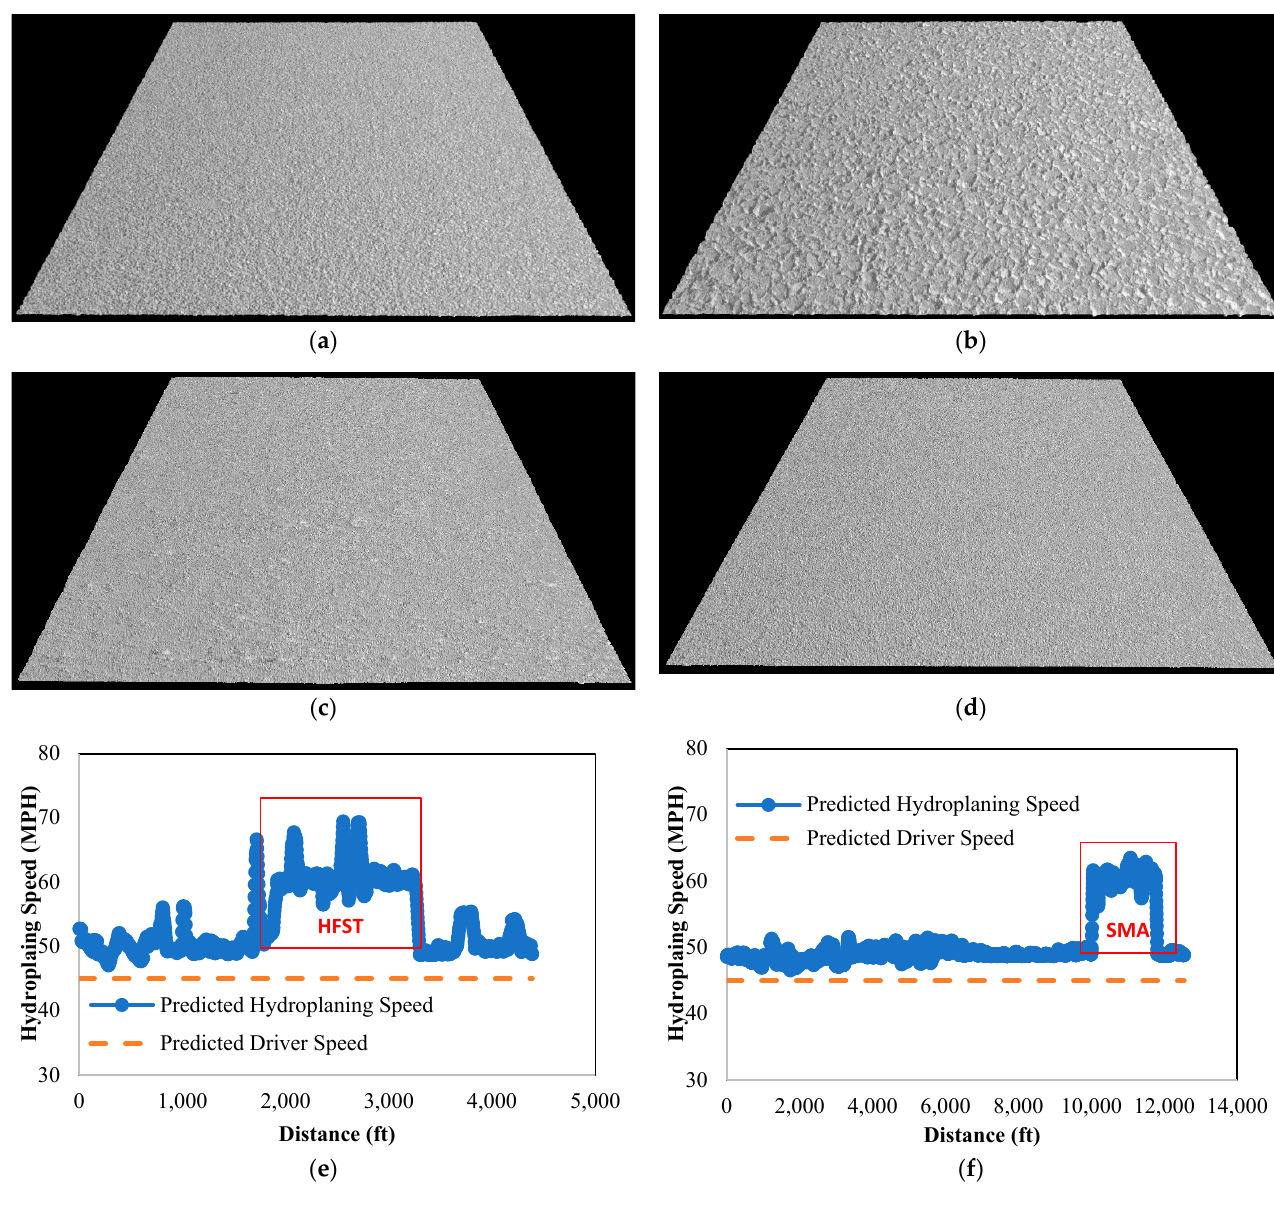
Figure 8. Hydroplaning speed prediction: ( a ) 0.1 mm 3D image of HFST (Site A), ( b ) 0.1 mm 3D image of SMA (Site B), ( c ) 0.1 mm 3D image of PCC (Site A), ( d ) 0.1 mm 3D image of AC (Site B), ( e ) Hydroplaning speed of Site A, and ( f ) Hydroplaning speed of Site B.